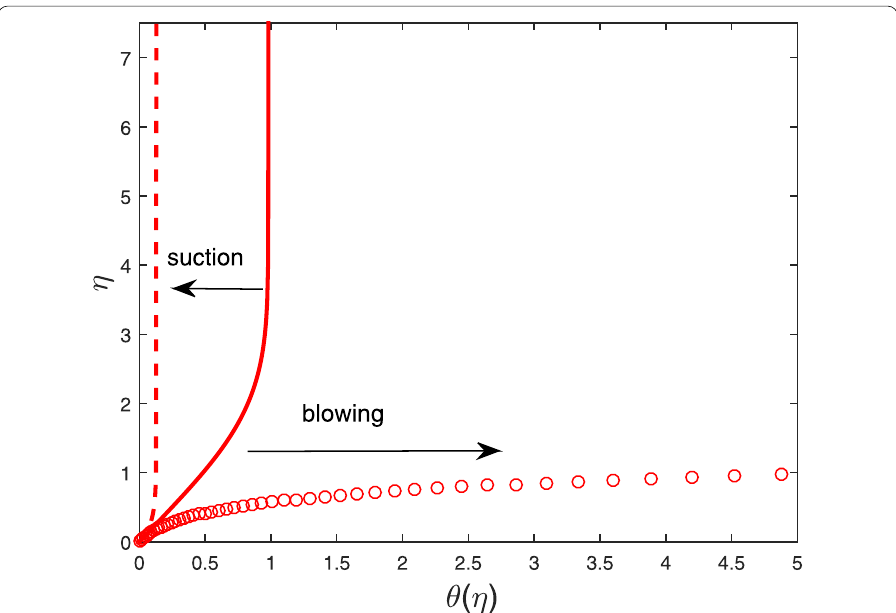
Fig. 4 Effect of normal mass flux blowing on the dimensionless temperature θ , from left to right: f w 0, ‐ 5, representing negative blowing-suction, standard case and blowing, respectively